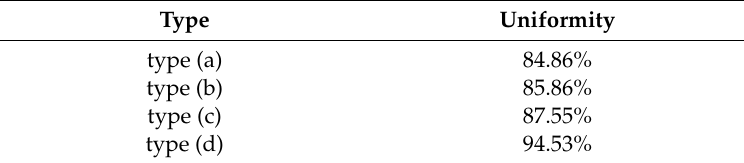
Figure 12. Simulation results of each type: ( a ) Results of type (a), ( b ) Results of type (b), ( c ) Results of type (c), ( d ) Results of type (d). Table 6. Uniformity of type A of each design variables simulation results.